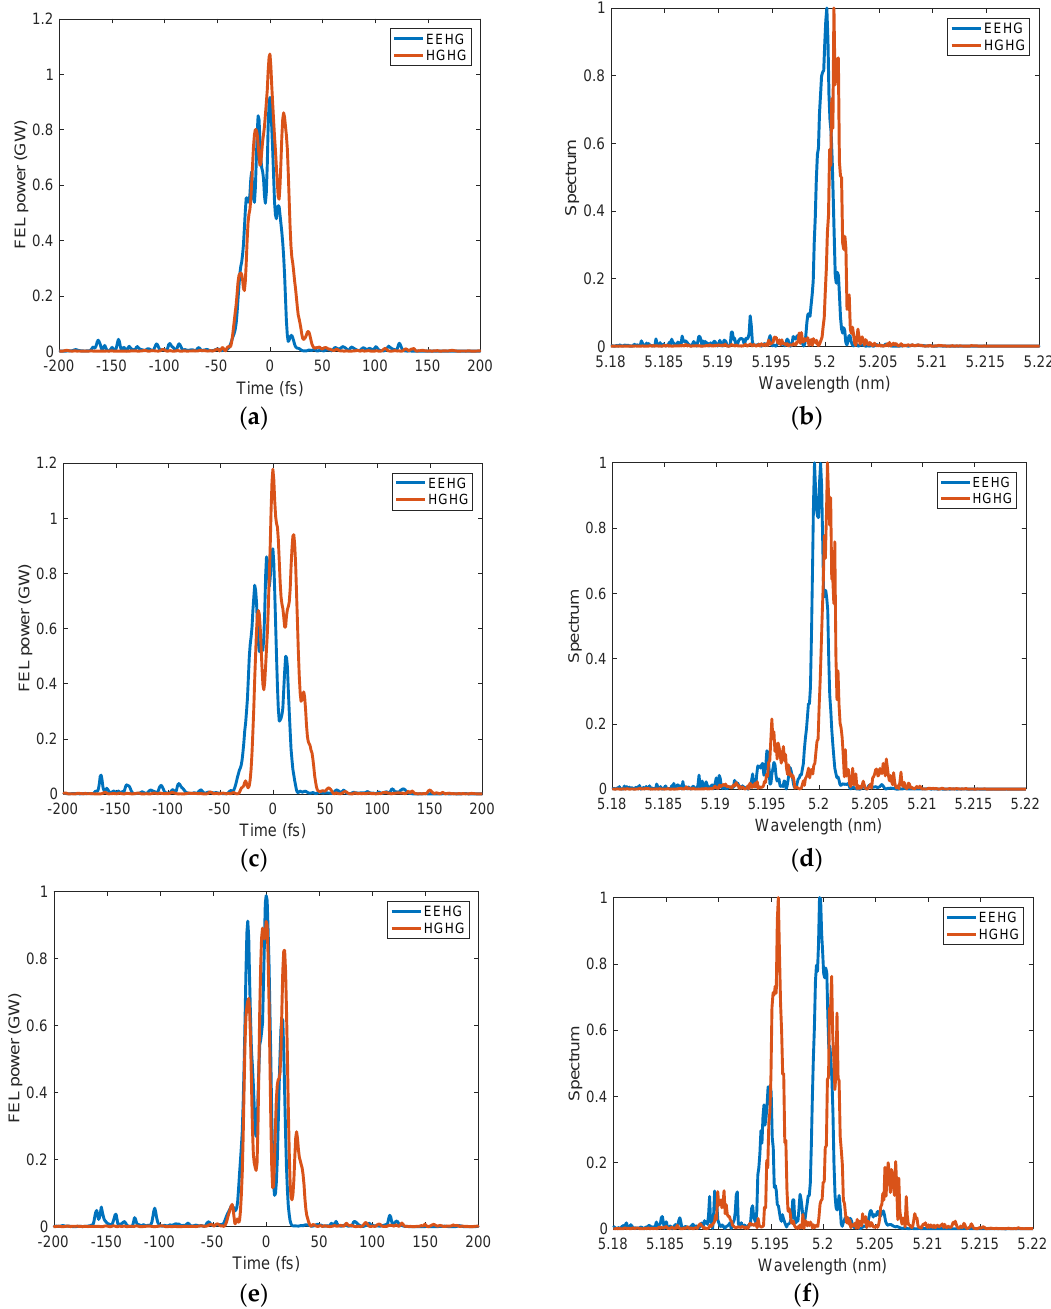
Figure 3. Comparison of the EEHG and the double-stage HGHG cascade for different e-beam energy profiles. ( a , b ) were obtained using the continuous profile in Figure 2. ( c , d ) are simulations results for an e-beam modulated at 5 μm with a 50 keV amplitude (Figure 2, dashed profile). In ( e , f ), the modulation amplitude was increased to 100 keV. The spectra in the right column are normalized to the central peak for each FEL scheme.